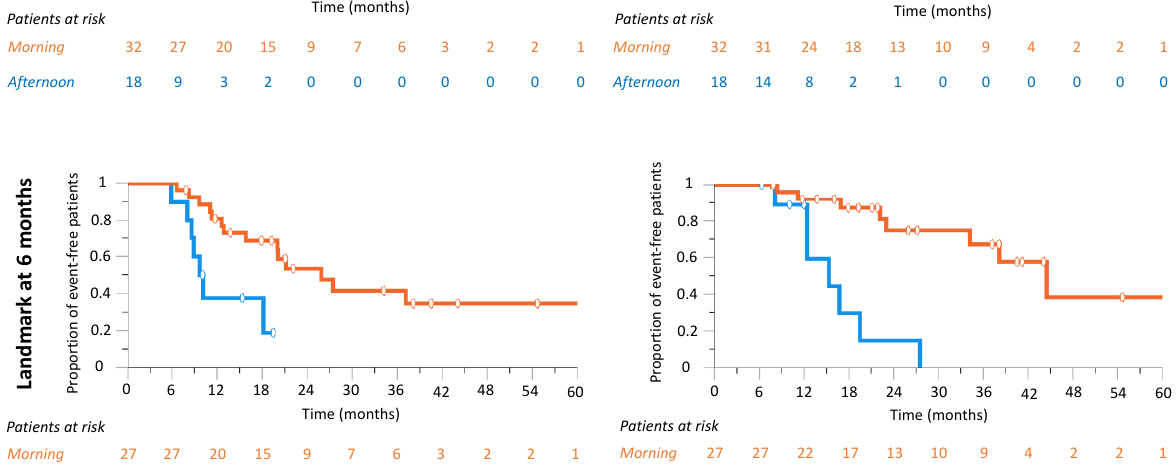
Figure 3. Progression-free survival (PFS) and overall survival (OS) landmark analysis by nivolumab timing group at 2, 4 and 6 months of exposure to